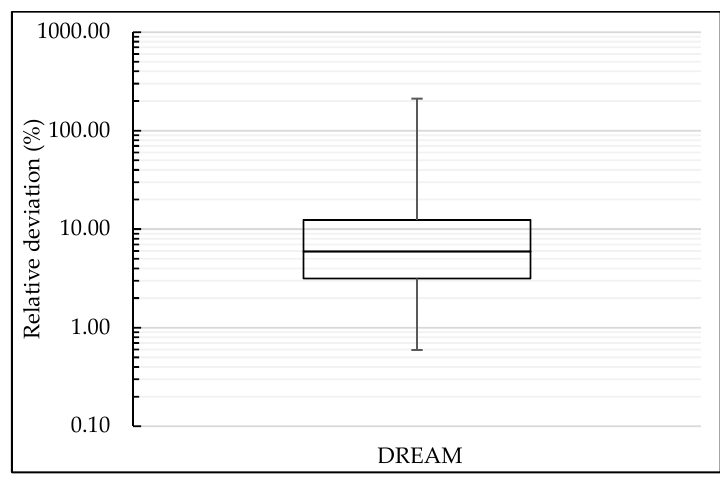
Figure 11. Boxplot of relative deviation (logarithmical scale) and points on the outlier results—GLUE.